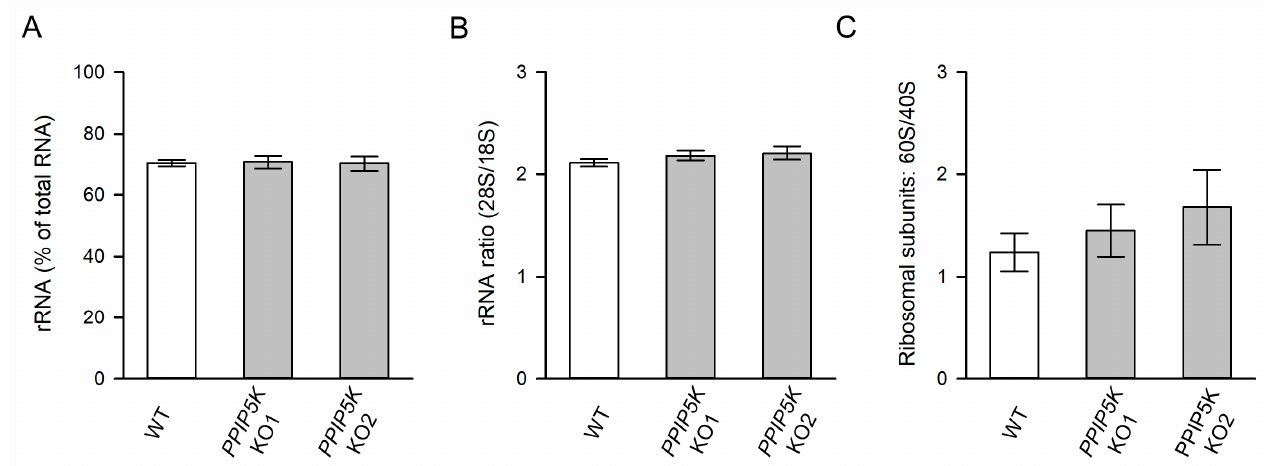
Figure 3. Analysis of ribosome production in wild-type and PPIP5K KO HCT116 cells. ( A ) Ribosomal RNA (rRNA) levels, ( B ) 28S/18S rRNA ratios, and ( C ) Ratios of 60S:40S ribosomal subunits, in wild-type HCT116 cells (open bars) and PPIP5K KO1 and KO2 HCT116 cells (gray bars), with standard errors, from five independent experiments. No statistically significant effects of the PPIP5K KO were observed ( p > 0.05).